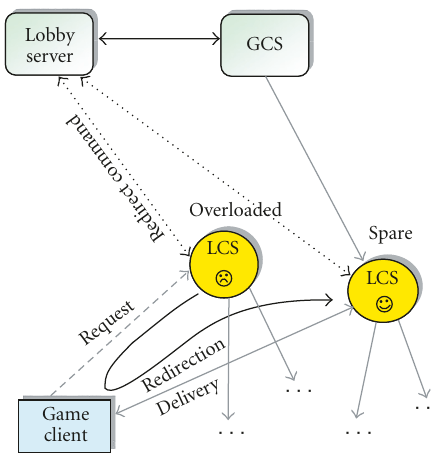
Figure 11: Dynamic load balancing mechanism.